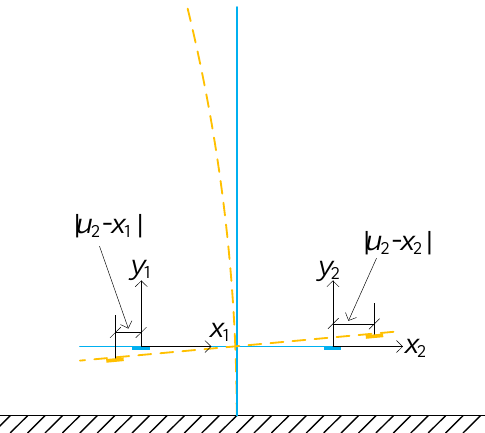
Figure 6. The un-deformed (in solid lines) and deformed (in dashed lines) configuration of the blade-damper system.